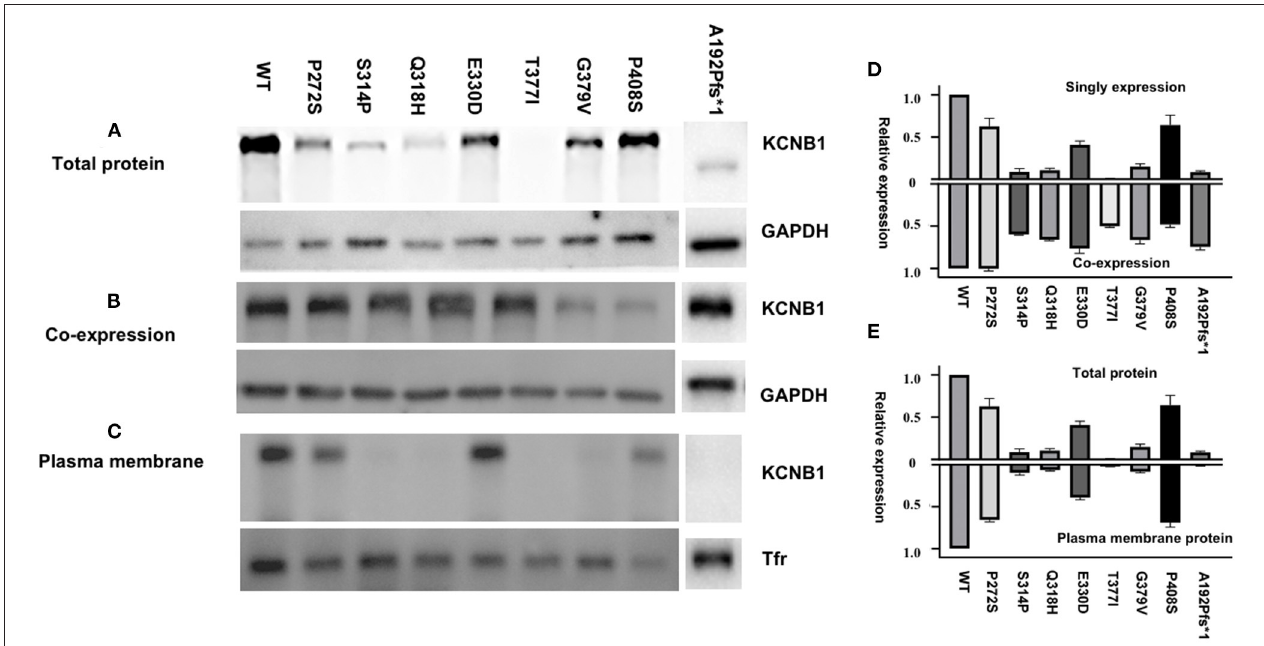
FIGURE 3 | Total and cell-surface protein expression levels of KCNB1 variants. (A,C) Mutant Kv2.1 proteins were expressed and trafficked to the cell surface. (B) Representative western blot of total protein expression of KCNB1 variants in heteromeric models. (D) Comparison of KCNB1 protein expression levels of detected variants and wild-type in both configurations. (E) Plasma membrane trafficking efficiency of Kv2.1 channels in CHO-K1 transfected with KCNB1 variants compared to the wild-type.